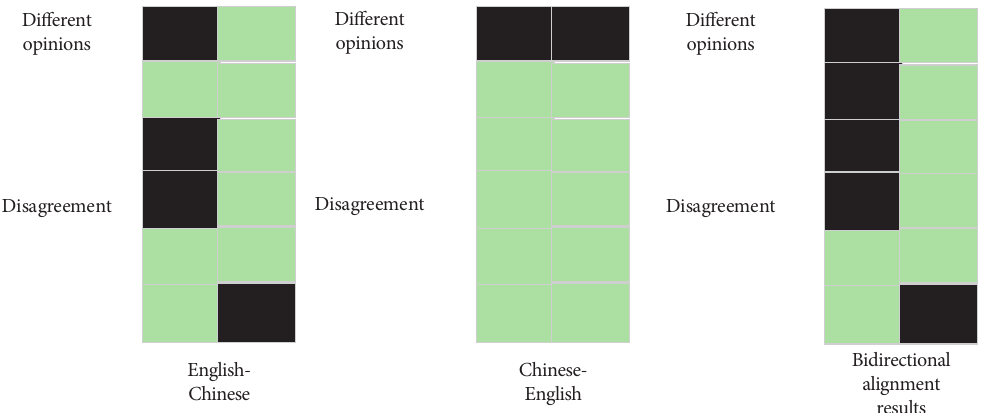
Figure 2: Schematic diagram of the alignment matrix of the wrong sentence